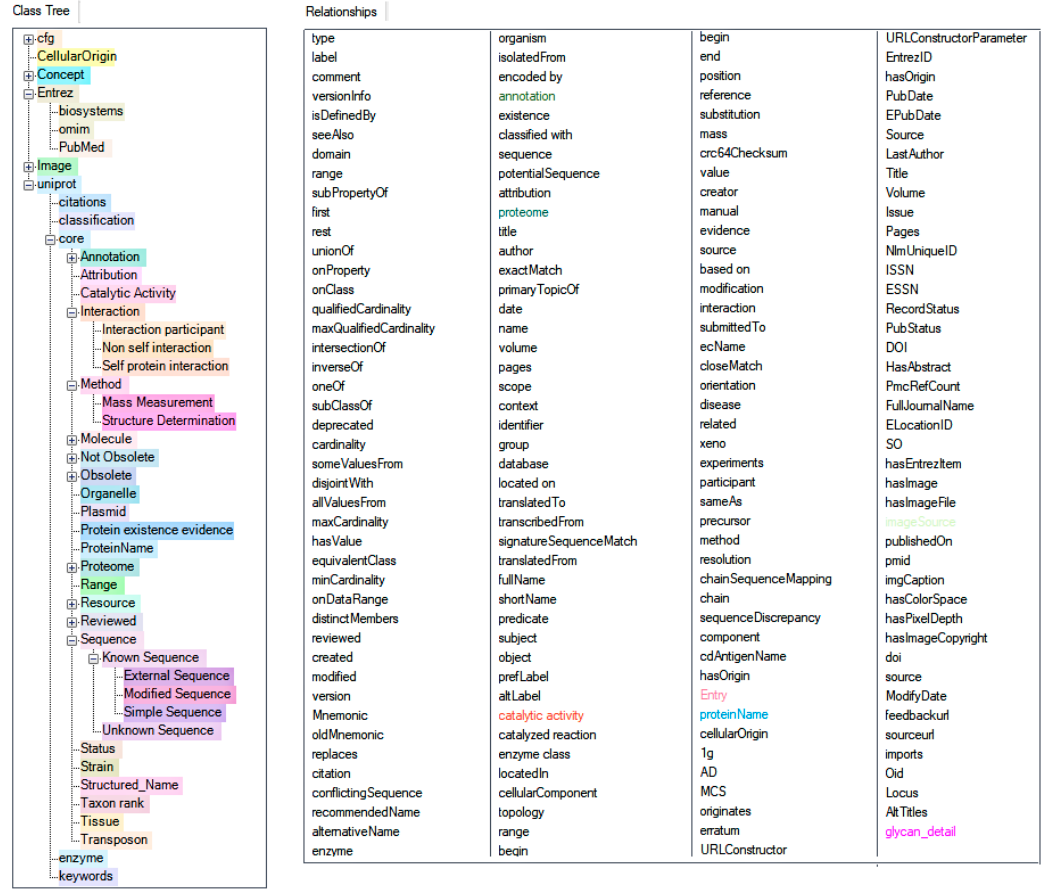
Figure 6. The dynamic generated applications ontology and relationships in the KE Knowledge Graph. Left panel: class tree with partially expanded subclasses; right panel: relationships between class entities. The colorization of the classes allows for easy distinction of their instances in the knowledge graph. All Entrez databases are displayed in light brown shades. Subclass colors are shades of the color of the corresponding root class.